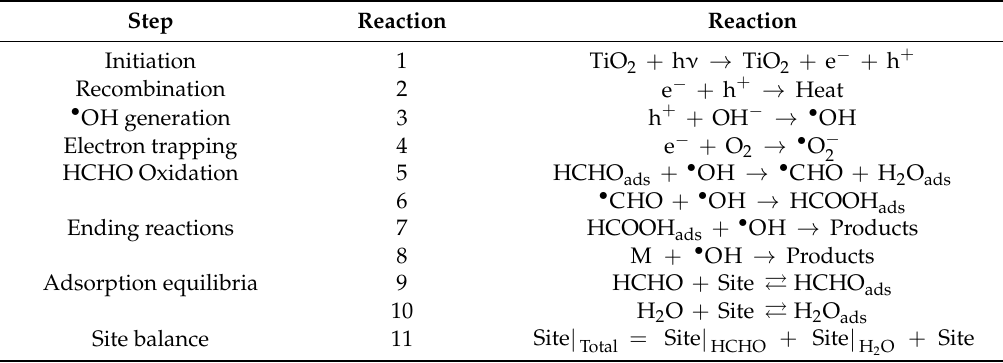
Table 2. Kinetic pathway for formaldehyde (HCHO)